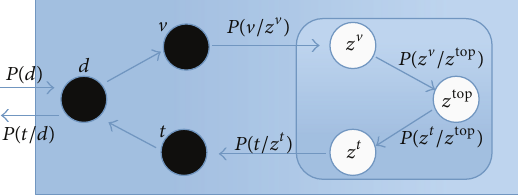
Figure 7: The calculating principle of the double-layer PLSA. annotation process are, respectively, shown in Algorithm 1 and Figure 8.